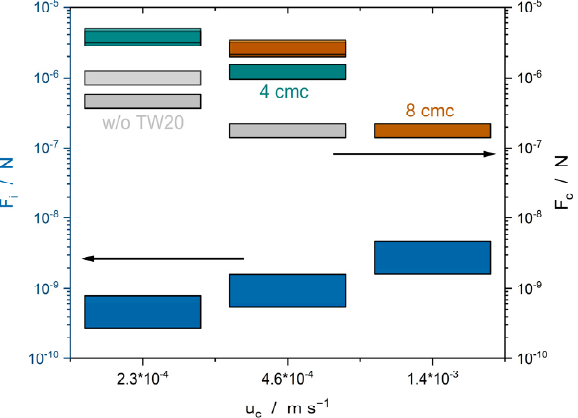
Figure 14. Force F i acting on the droplet due to the impulse (Equation (7)), and the force due Figure 14. Force 𝐹 (cid:3036) acting on the droplet due to the impulse (Equation (7)), and the force due to the flow field after the contact 𝐹 (cid:3030) (Equation (6)) for three different velocities of the continuous phase to the flow field after the contact F c (Equation (6)) for three different velocities of the continuous and three aqueous surfactant concentrations 𝑐̃ (cid:3021)(cid:3024)(cid:2870)(cid:2868) (without ( w / o ) TW20, 4 𝑐𝑚𝑐 or 8 𝑐𝑚𝑐 ). A cross- phase and three aqueous surfactant concentrations (cid:101) c TW 20 (without ( w / o ) TW20, 4 cmc or 8 cmc ). A sectional area of 𝐴 (cid:3030)(cid:3035)(cid:3028)(cid:3041)(cid:3041)(cid:3032)(cid:3039) = 6 ⋅ 10 (cid:2879)(cid:2876) m 2 was used for the calculations. cross-sectional area of A channel = 6 · 10 − 8 m 2 was used for the